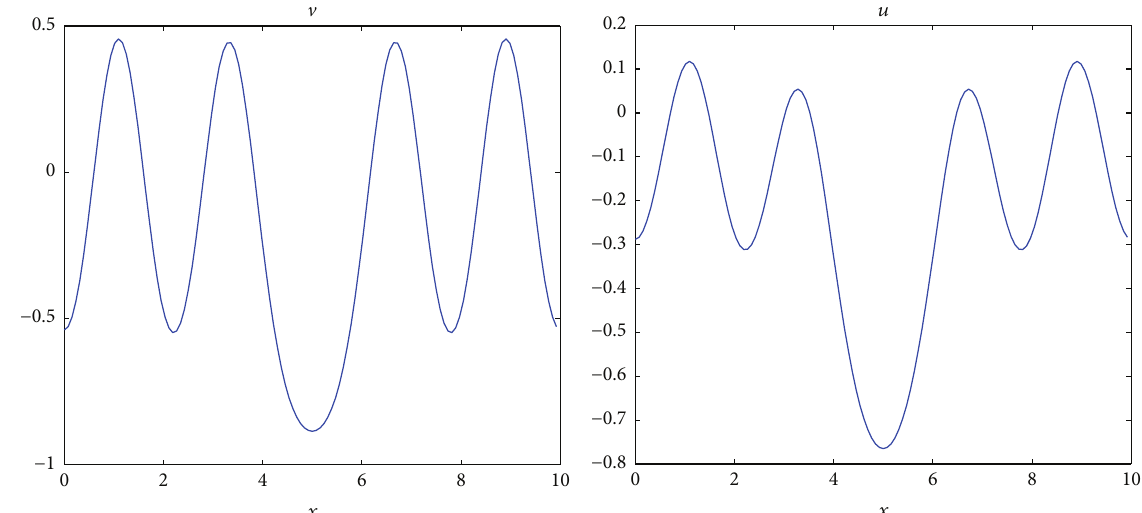
Figure 3: Periodic travelling wave solution of system (75) for 𝛼 = 𝛽 = 1 , 𝜎 = 0.01 , wave speed 𝑐 = 0.5 , and period 𝐿 = 10 , obtained after 21 Newton’s